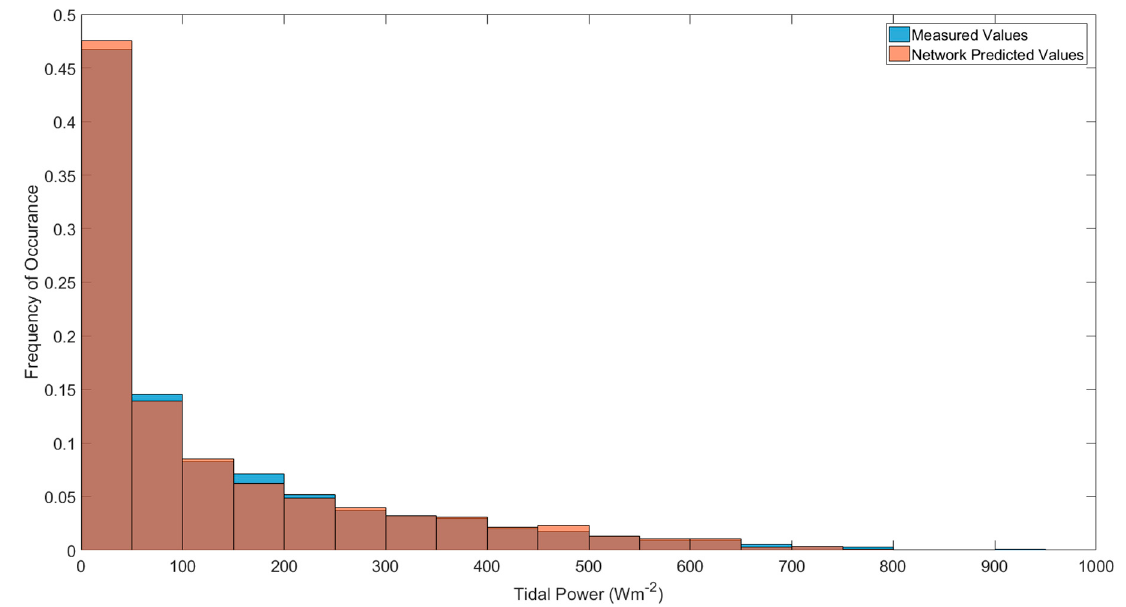
Figure 8. ADCP measured and neural network predicted frequency of tidal power occurrence separated into 50 Wm − 2 bins. Blue: measured values, and orange: network prediction.